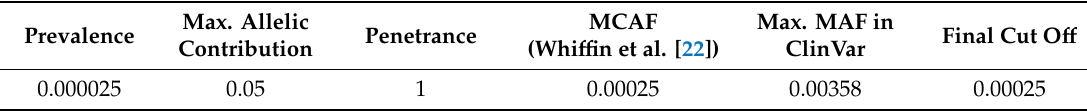
Table 1. Maximum Credible Allele Frequency (MCAF): Allelic Contribution, Penetrance, MAF cuto ff , pathogenic variants in ClinVar from Trusted submitters and final MAF cuto ff